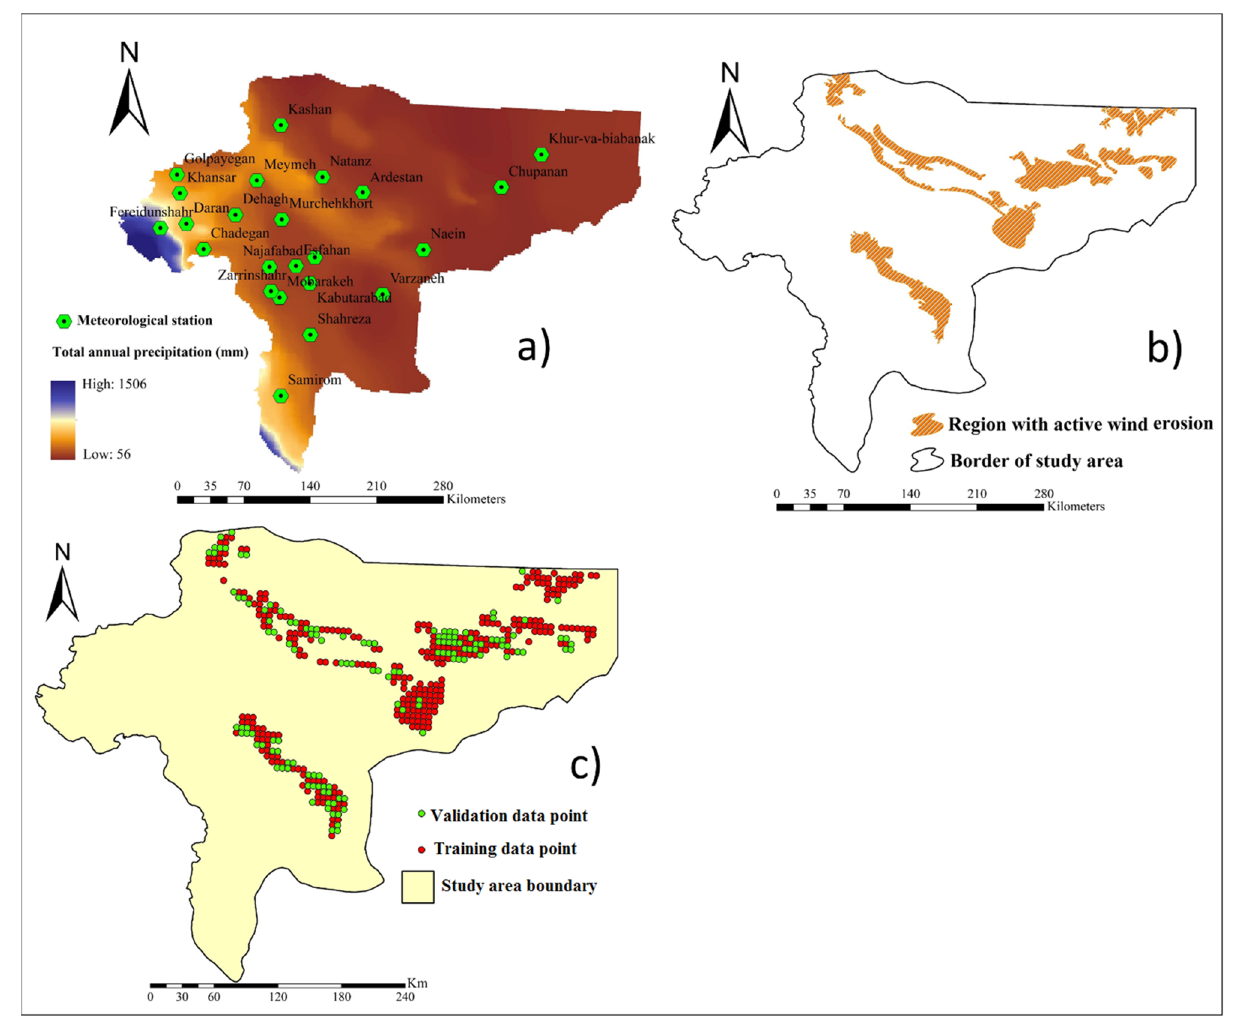
Figure 10. Spatial maps of: (a) total annual precipitation; (b) locations of the pixels with active wind erosion, and; (c) locations of the training and validation data points. All these characteristics were mapped spatially in ArcGIS 10.4.1 (https ://www.esri.com/en-us/about /about -esri/overv